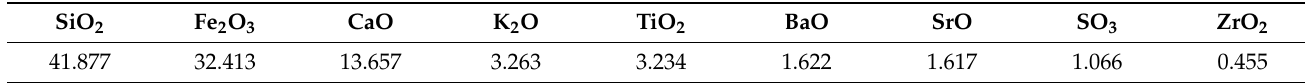
Table 3. The chemical composition of the fly ash.